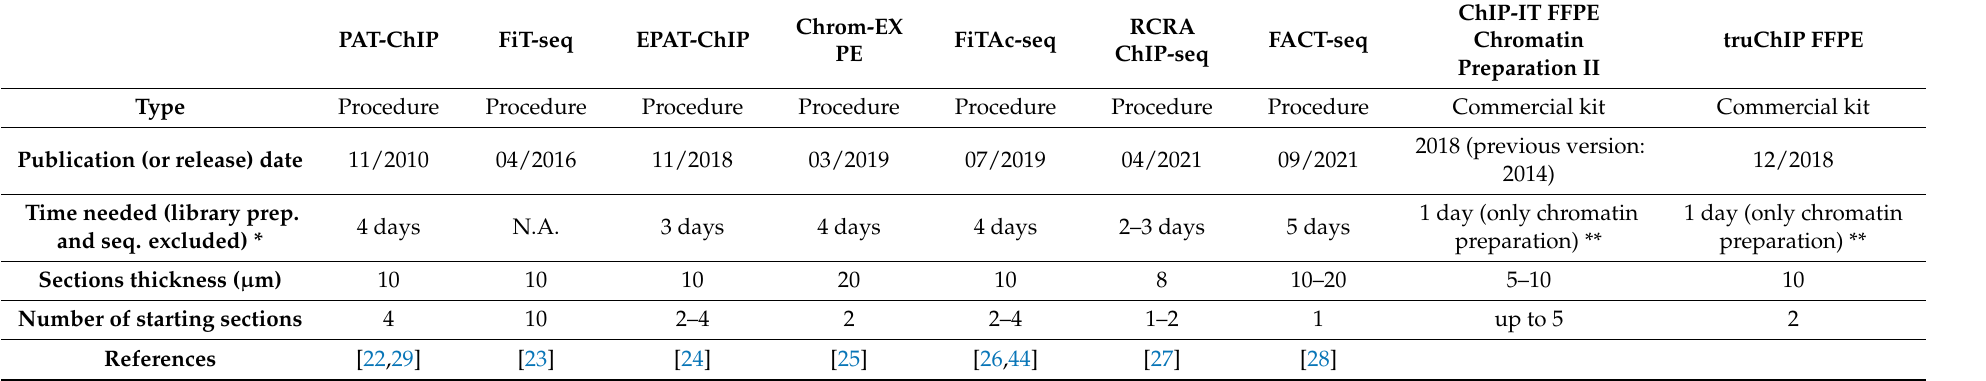
Table 1. Overview of the FFPE-ChIP procedures and kits analyzed in this